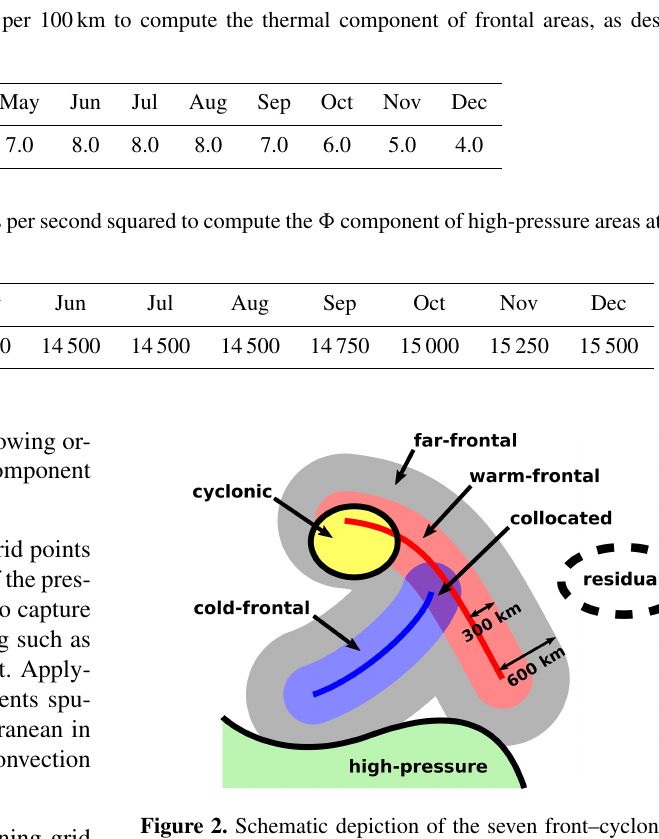
Figure 2. Schematic depiction of the seven front–cyclone-relative components (as defined in Sect. 2.5): high-pressure, cyclonic, cold- frontal, warm-frontal, collocated, far-frontal, and residual. Note that they are mutually exclusive and cover the whole domain; i.e., at a given time step, each grid point is assigned to exactly one compo-